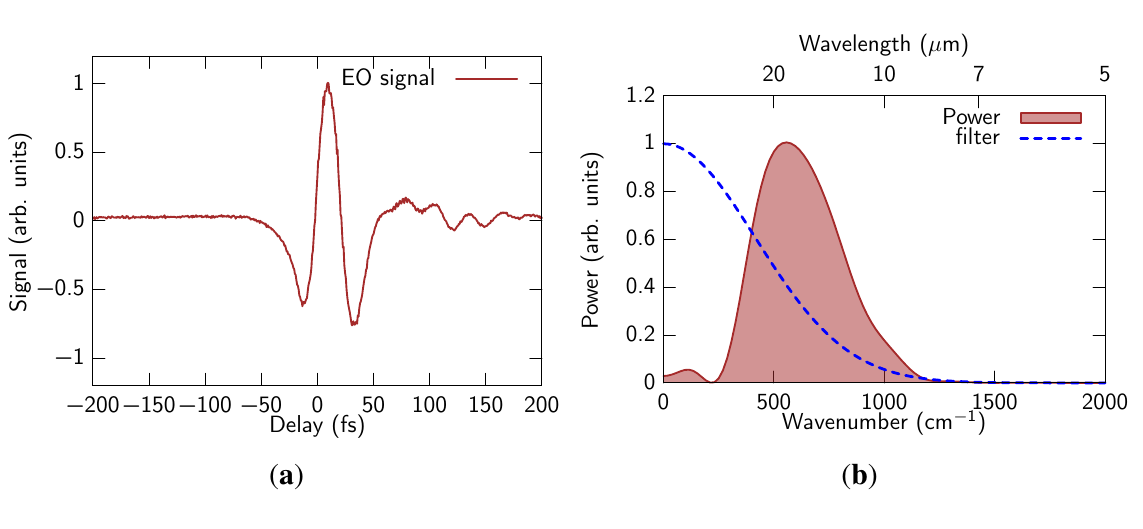
Figure 4. ( a ) Signal of gas-biased coherent detection and ( b ) power spectrum obtained with Fourier analysis. The dashed line is filtering function described in the